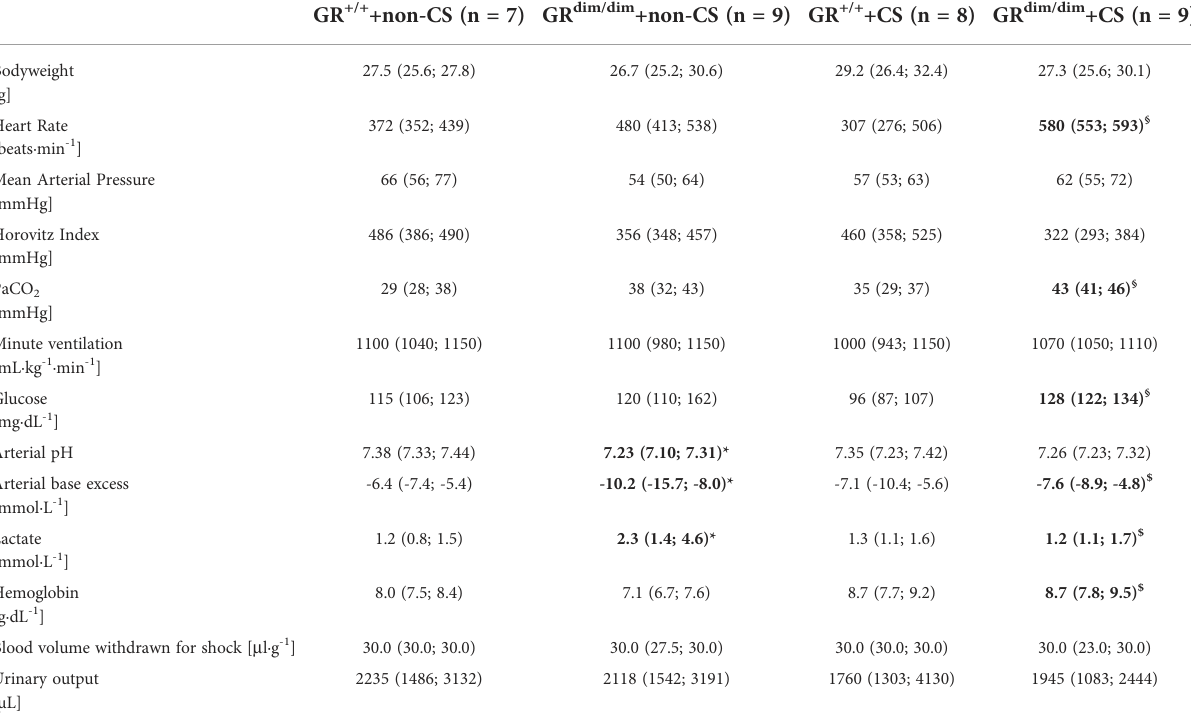
TABLE 1 Hemodynamic and metabolic measurements as well as ventilation parameters in GR dim/dim and GR +/+ mice with or without cigarette- smoke (CS) exposure and after hemorrhagic shock(HS) with subsequent resuscitation (4h) at the end of the experiment.